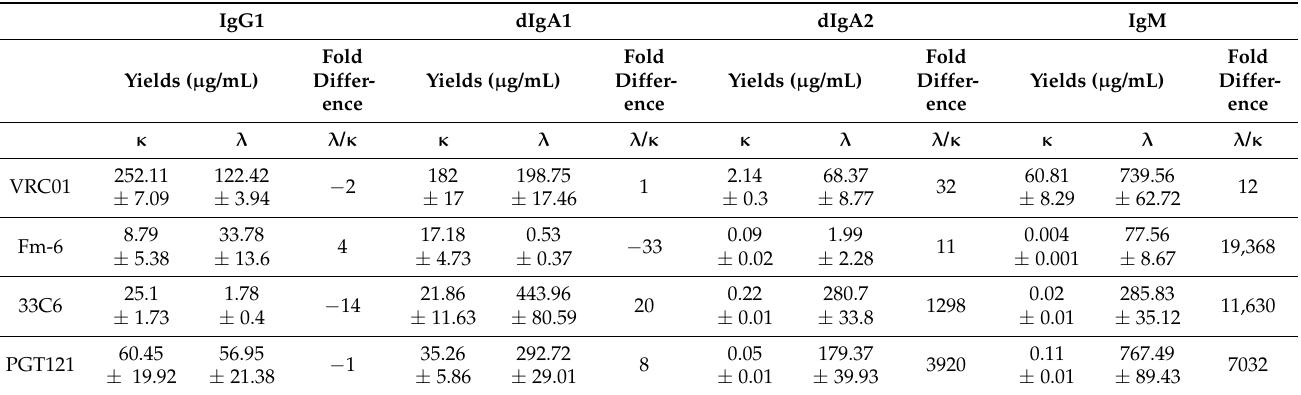
Table 1. Fold change in expression levels of antigen-specific mAbs when pairing heavy chains with λ versus κ light chains.